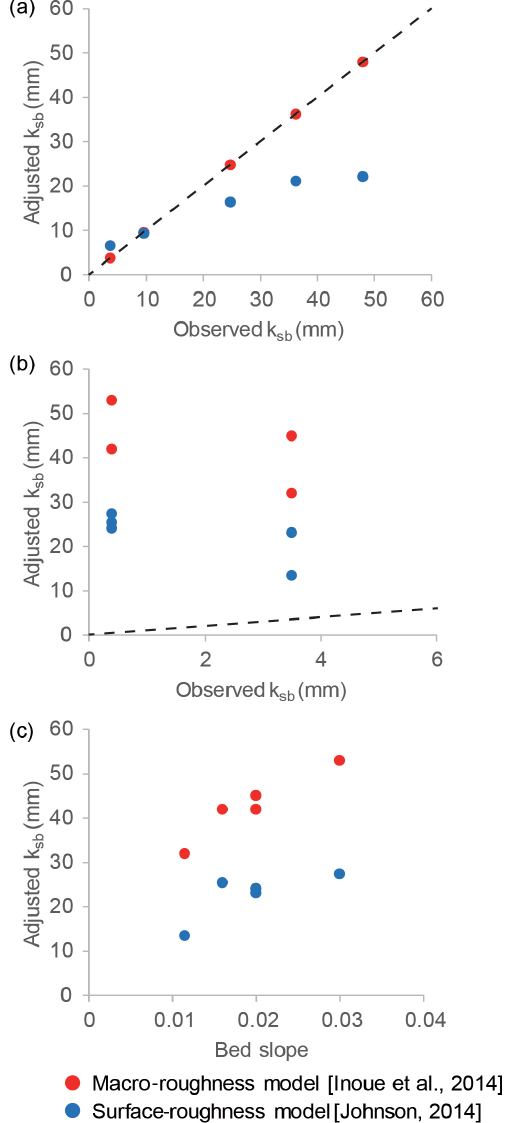
Figure 14. (a) Comparison between adjusted and observed hy- draulic roughness height of bedrock bed for our experiments. k sb for the macro-roughness model is equal to the observed values be- cause there was no need for adjustment. (b) Comparison between adjusted and observed hydraulic roughness height of bedrock bed for the experiments conducted by Chatanantavet and Parker (2008). (c) Sensitivity of adjusted k sb to bed slope S for experiments con- ducted by Chatanantavet and Parker (2008). Note: The black dotted line is the 1:1